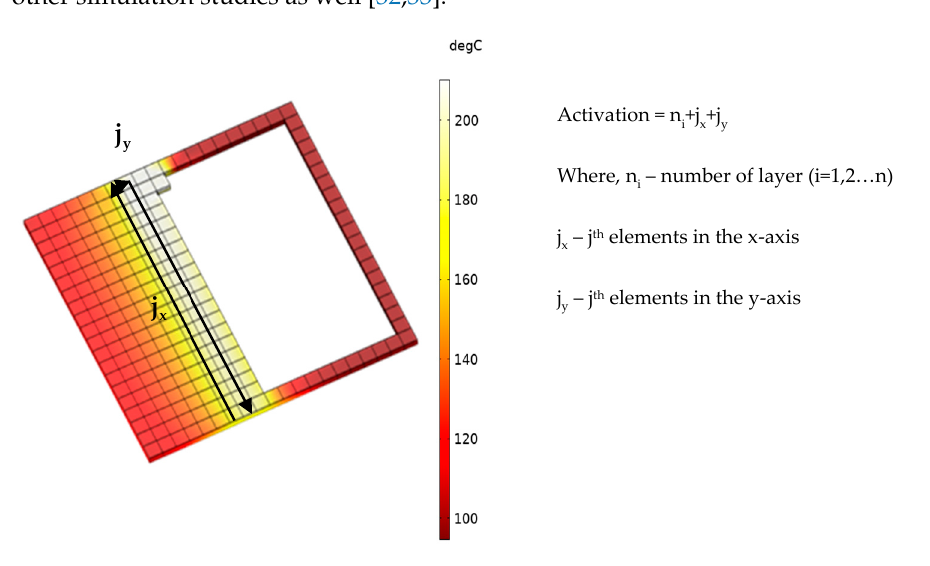
Figure 2. Representation of element activation with respect to the material deposition.